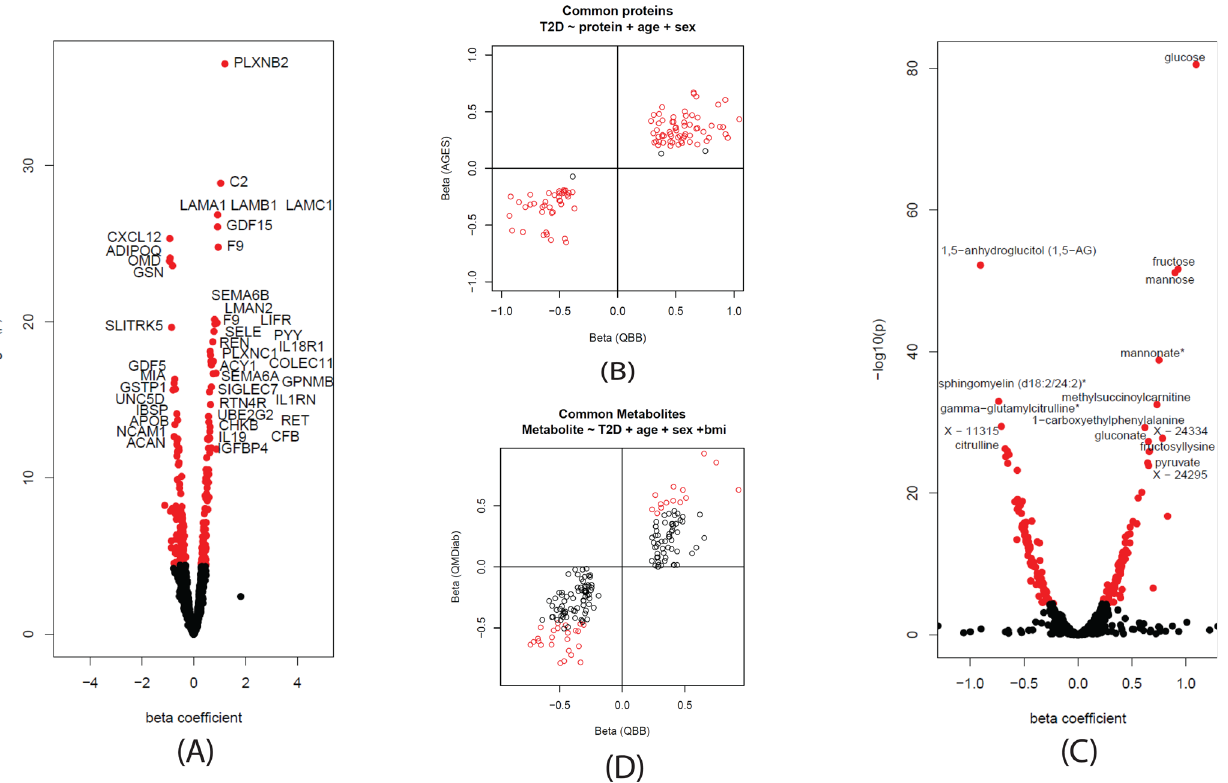
Fig.3|AssociationsofproteomicsandmetabolomicslevelswithT2D.A Usinga linear model, 214 proteins were signi fi cantly associated at a Bonferroni level of signi fi cance( p <0.05/1305=3.83×10 − 5 )withT2DinQBBafteradjustingforageand sex. B Comparisonof effectsizesbetweenQBBandAGES.Thereplicationstatusof 107 common proteins is shown red: Bonferroni signi fi cant ( p <0.05/ 107=4.67×10 − 4 ) in both studies, black: signi fi cant only in QBB. C Using a linear